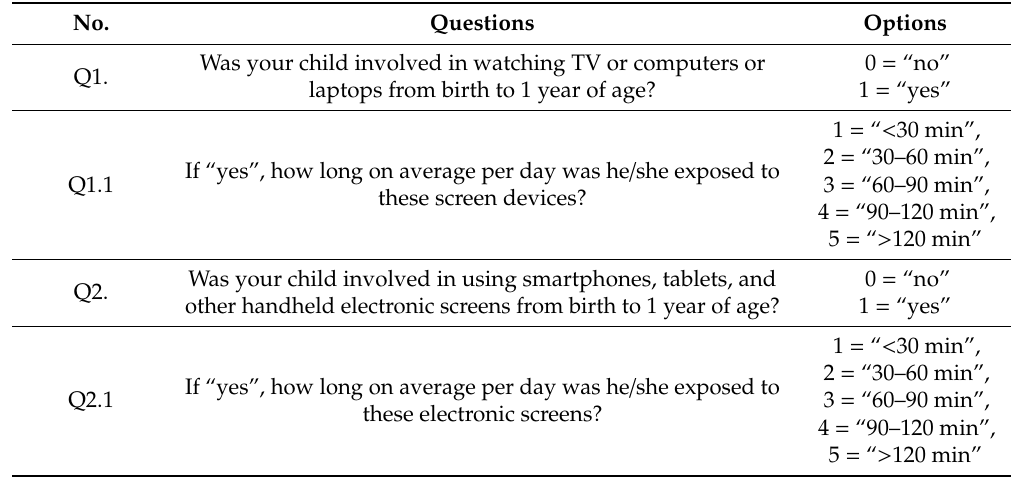
Table 1. Questions and options regarding screen exposure from birth to 1 year of